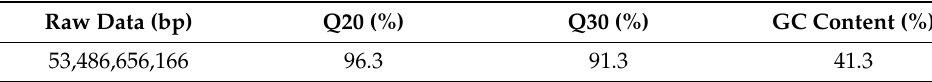
Table 1. Sequencing data for the genome of T. loennbergii . Raw Data